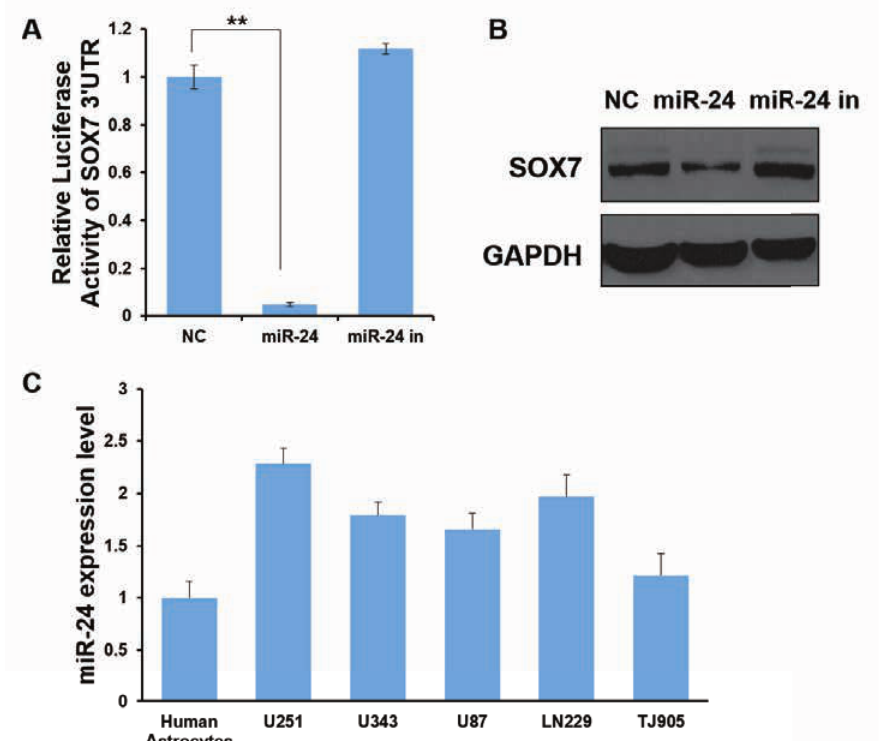
Figure 3: SOX7 might be a target of miR-24 in glioblastoma. (A) Luciferase reporter assays in U87 cells following co-transfection with 3’-UTR of SOX7 and miR-24 mimics or inhibitors, as indicated. Data are presented as means of three independent experiments. All data are shown as means ± SD. **P < 0.01. (B) U87 cells were transfected with 3’-UTR of SOX7 and miR-24 mimics or inhibitors, and SOX7 expression was measured via western blot. GAPDH was used as an internal control. (C) qPCR analysis of miR-24 in the GBM cell lines as in Figure 1B. Data were expressed as means ± SD. b -actin was used as an internal